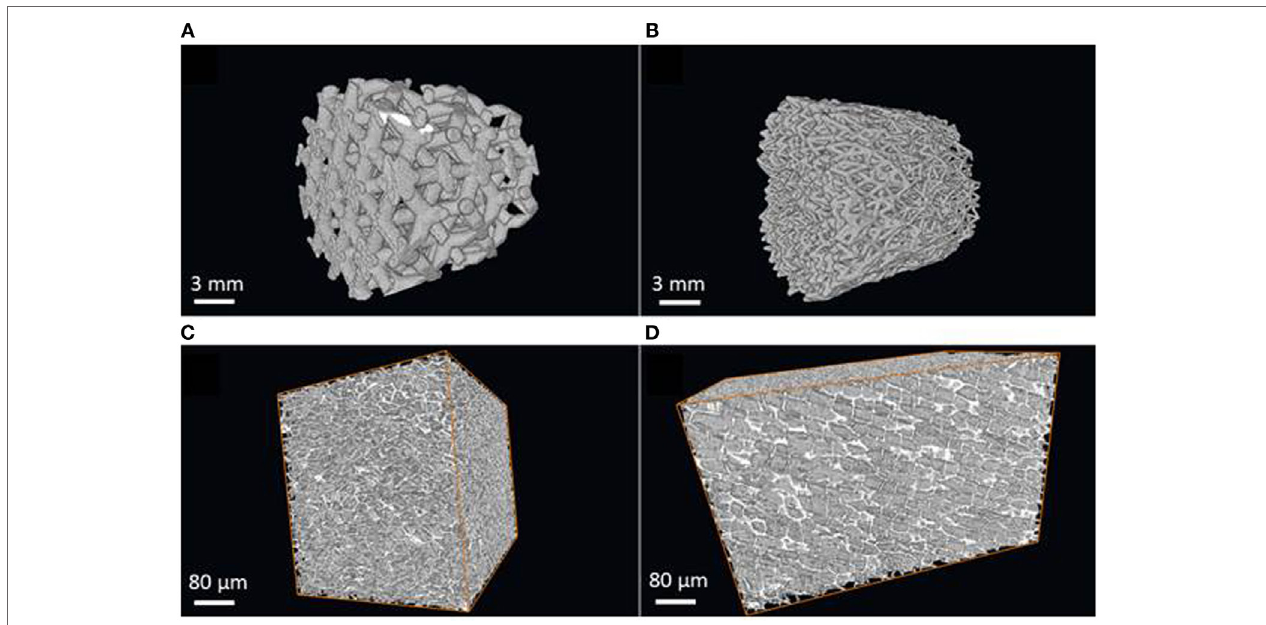
FigUre 3 | Three-dimensional structures that were used for ITA validation, as reconstructed μ CT images. (a) Dodecahedron-based metal lattice (D-lattice). (B) Stochastic metal lattice (S-lattice). (c) Cork viewed in the same plane as the natural surface of the tree, note hexagonal honeycomb-like structure in that projection. (D) Cork viewed in the radial direction. Note preferential alignment of cells in that